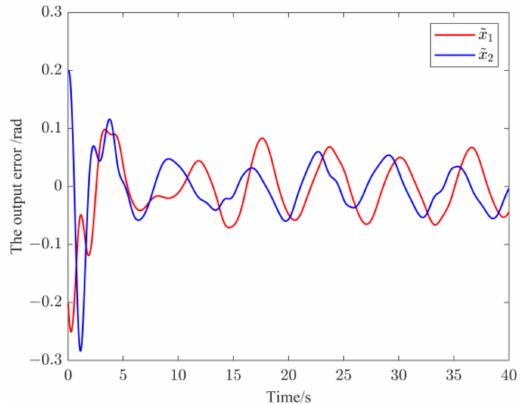
when u p is off. θ